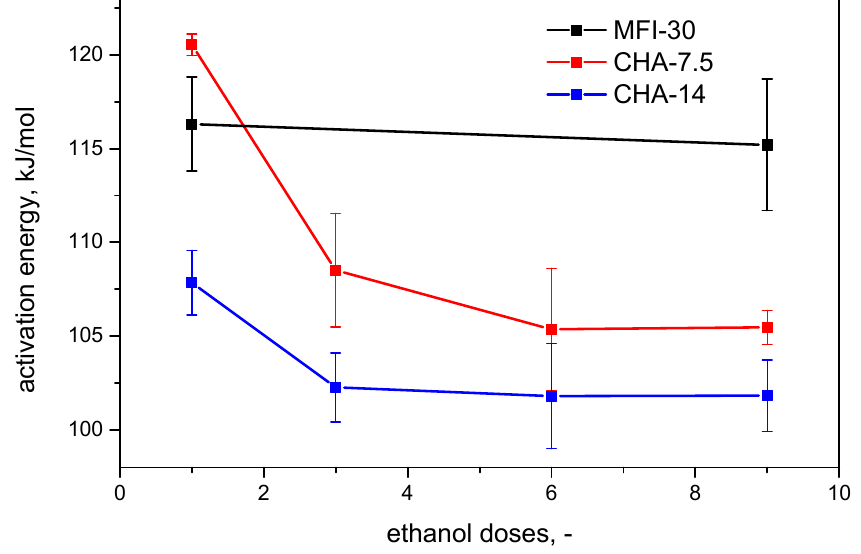
Figure 7. Apparent activation energy values obtained from TPSR experiments in dependence of number of ethanol doses.